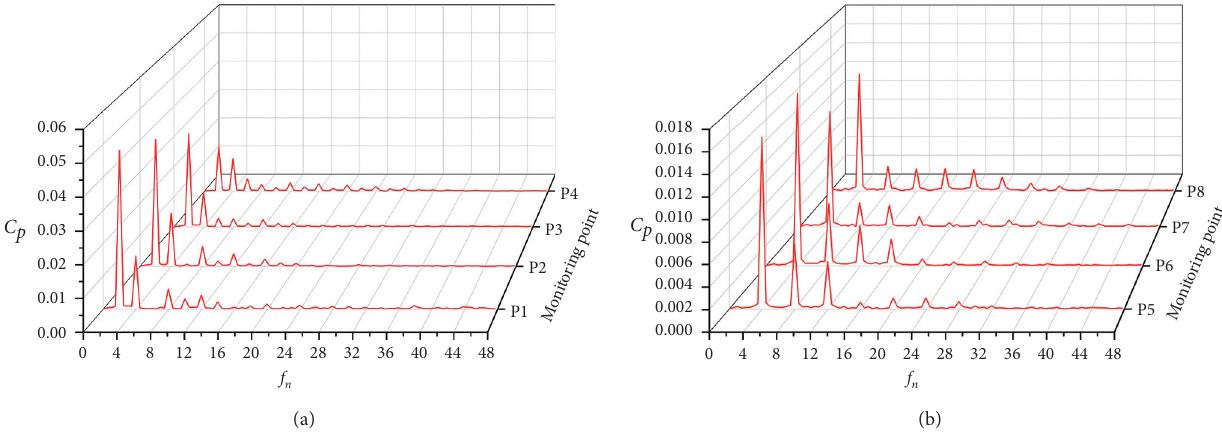
Figure 19: Frequency domain of each monitoring point at the impeller outlet ( Q � Q